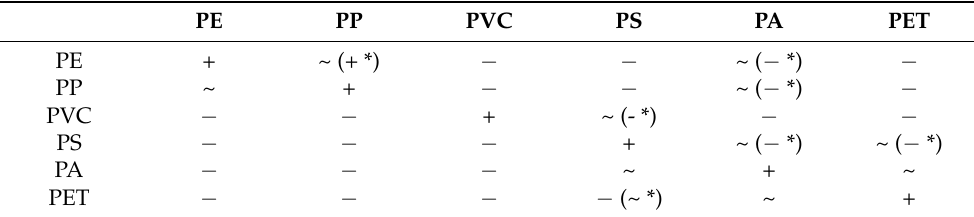
Table 2. Compatibility of polymers in recycling. Modified after works in [20]. * indicates differences in the comparison to the works in [93,98]. PE PP PVC PS PA PET PE + ~ (+